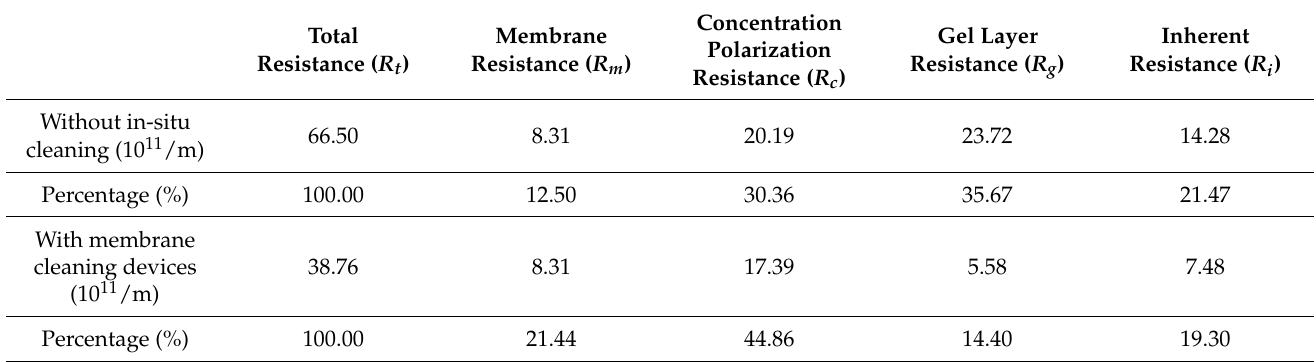
Table 2. Impact of the automatic cleaning device on membrane resistance